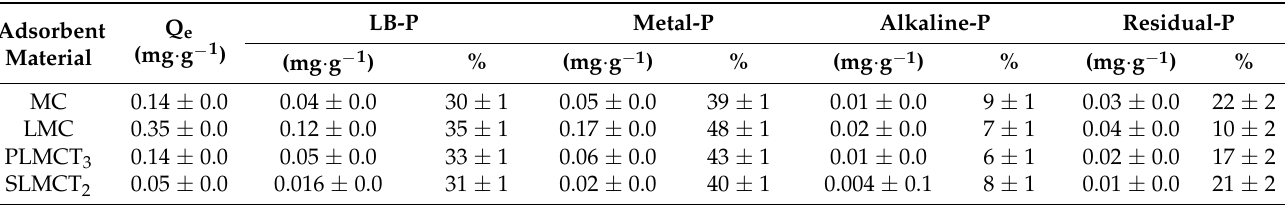
Table 5. Fractions of phosphate bonded to the